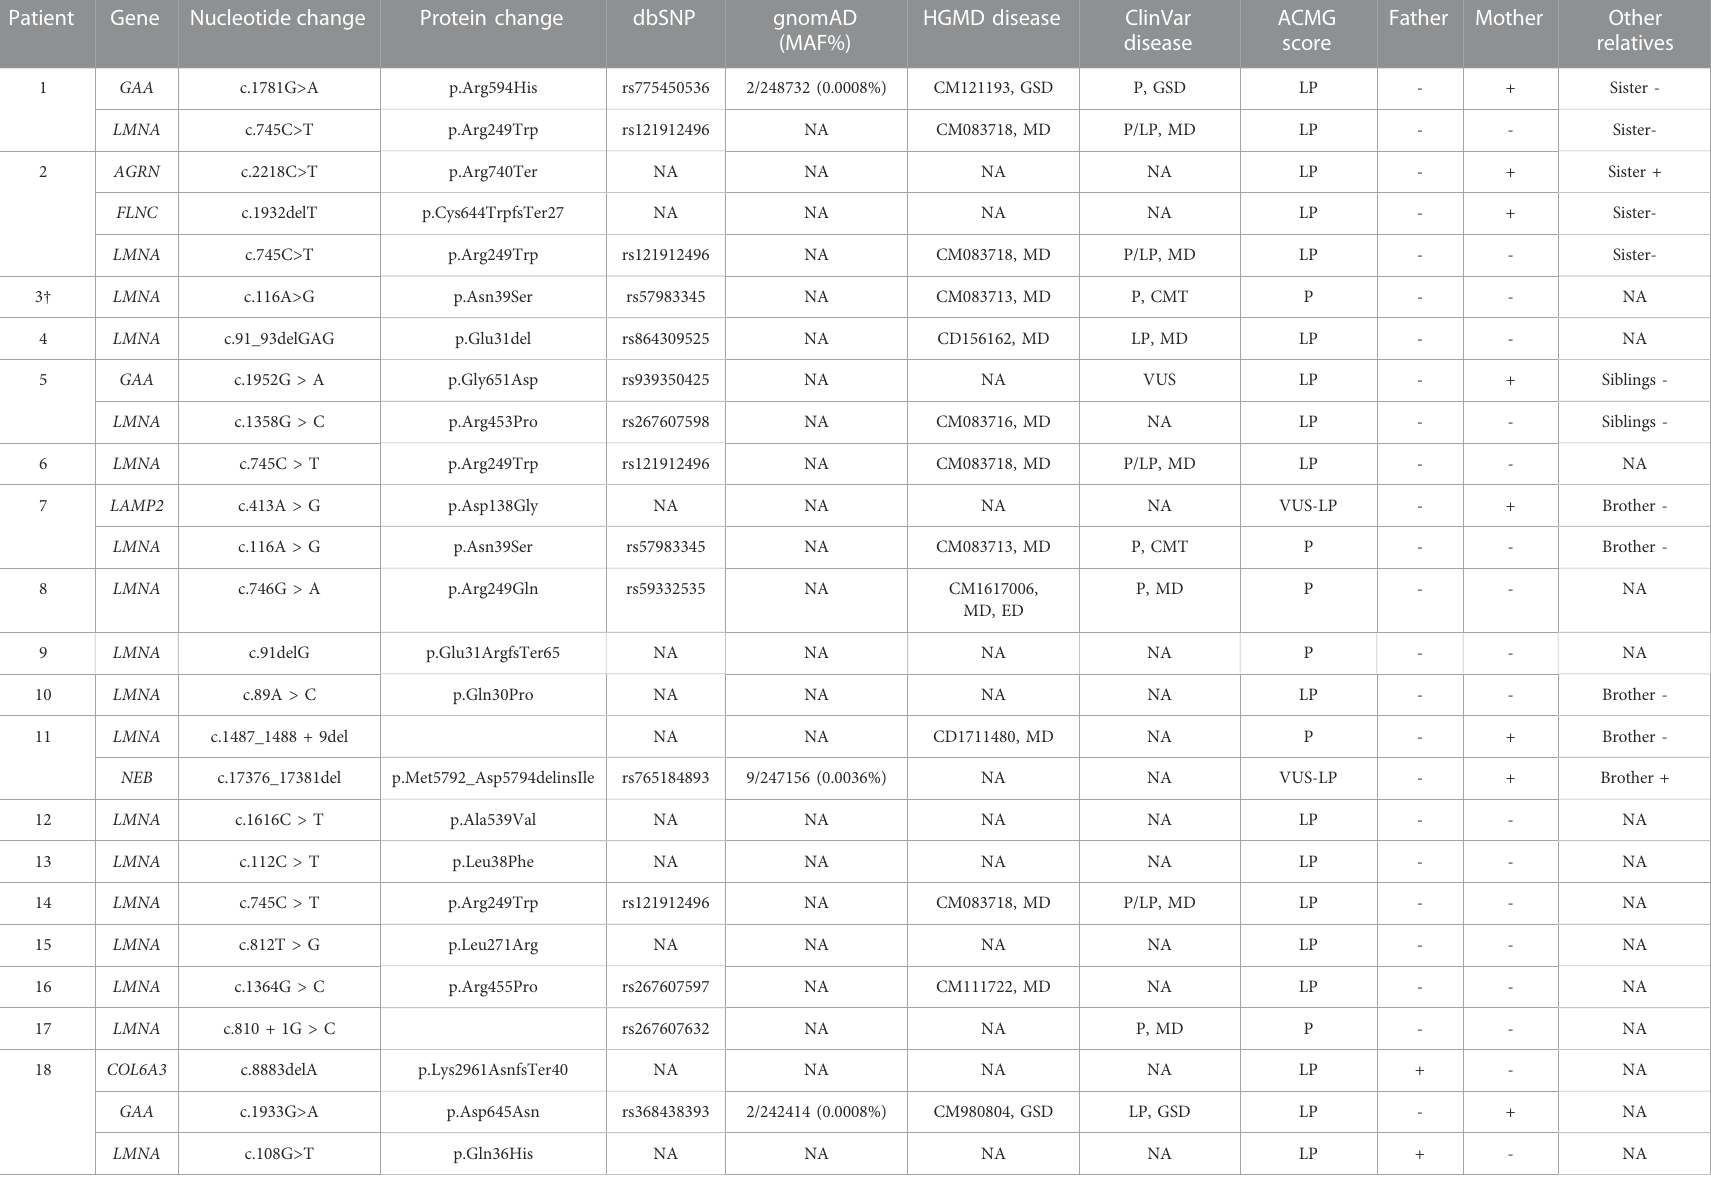
TABLE 3 LMNA variants and related features found in our pediatric